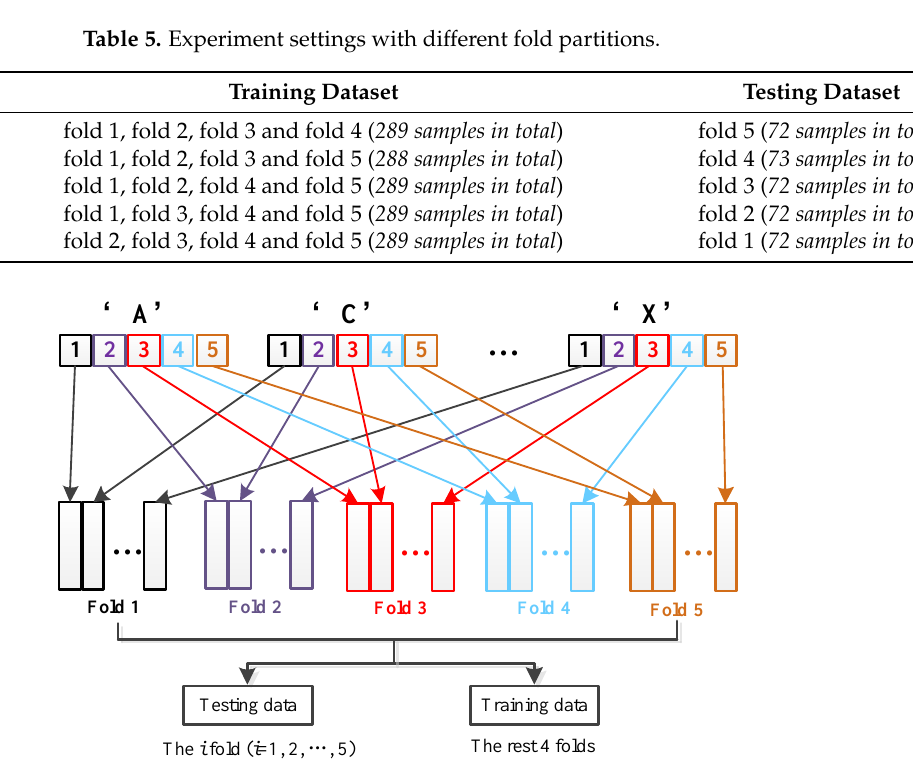
Figure 6. Five-fold cross verification scheme for asteroid spectral data.